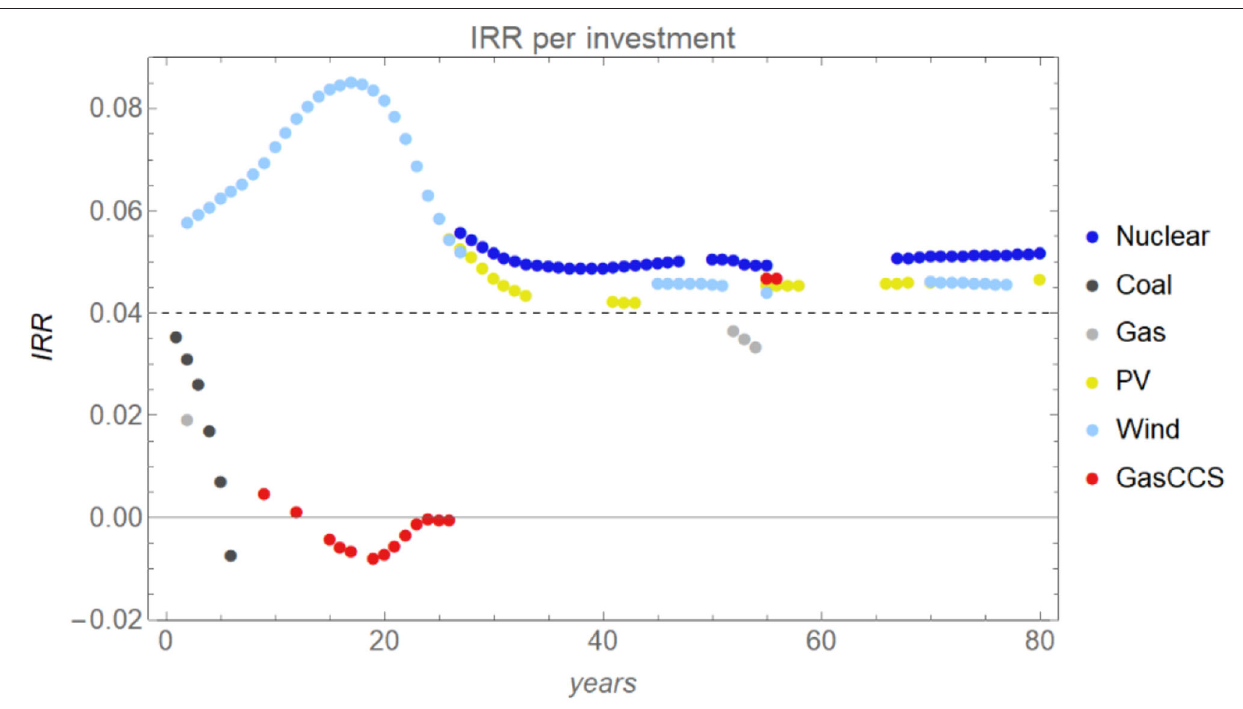
Frontiers in Climate |